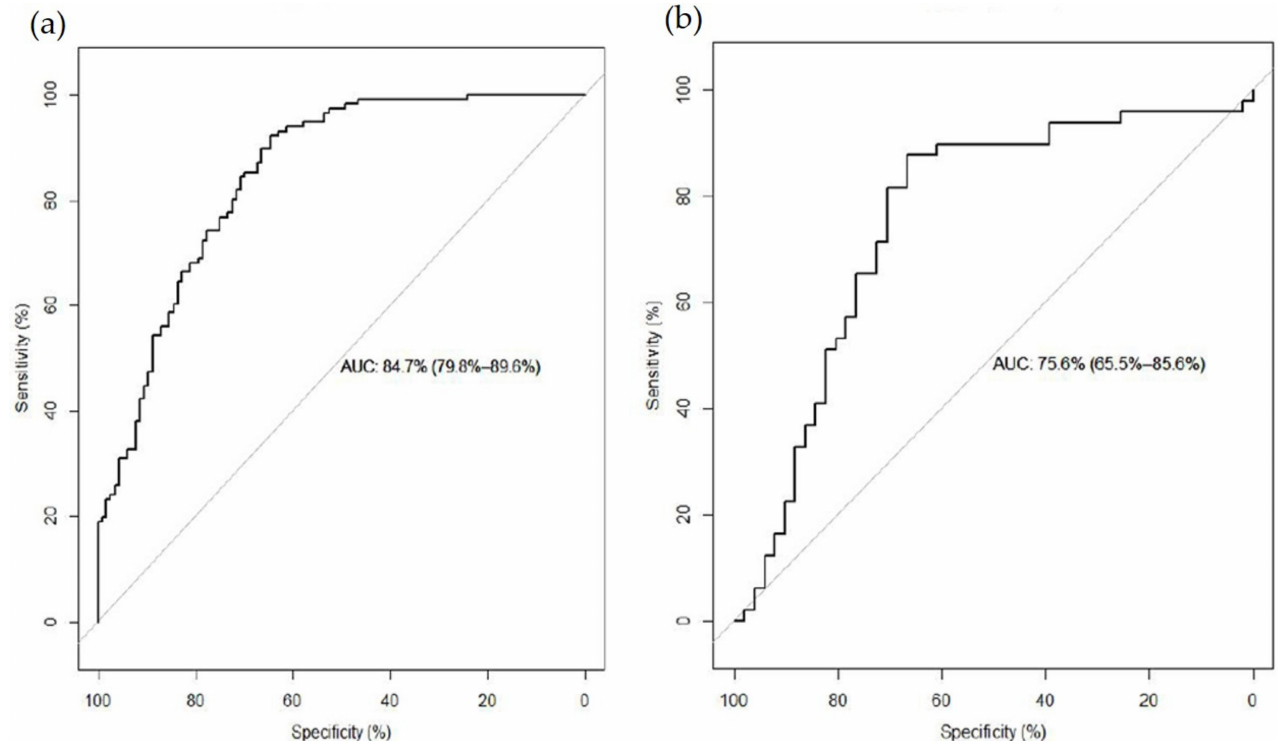
Figure 2. ( a ) Receiver operating characteristic curve of the combination of 11 differential metabolites between short-term red meat low consumers and high consumers in training set. ( b ) Receiver operating characteristic curve of the same metabolites in testing set for